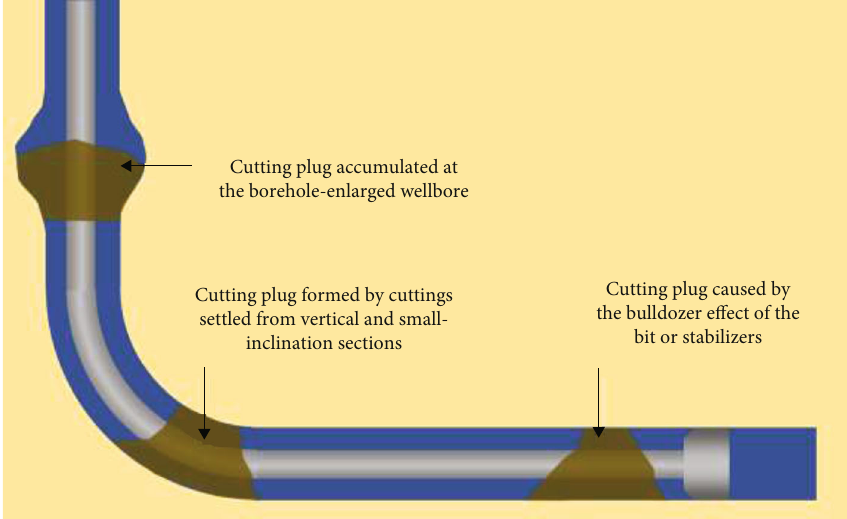
Figure 1: The sketch of cutting plugs formed in a shale horizontal well.